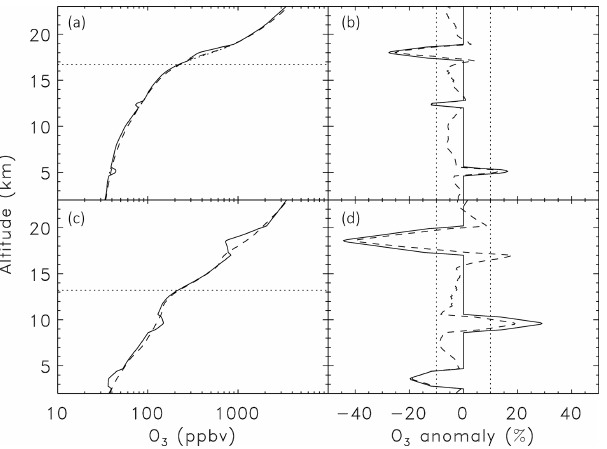
Figure 3. Panel (a) shows vertical profiles of ozone (blue) and scaled potential temperature anomalies (red) from a Boulder ozonesonde sounding on 4 May 2006. Vertical dashed lines rep- resent a 10% amplitude threshold for defining laminae, and seven identified laminae are indicated by number. Panel (b) shows the cor- relation coefficient calculated between ozone and potential temper- ature anomalies using a 5km wide sliding vertical window (solid curve), and alternatively from windows centered on individual lam- inae (orange and green bars). The dashed vertical line indicates the 0.7 threshold used for identifying gravity wave ozone laminae with the 5km sliding window technique. For correlations over individual laminae, a 0.65 threshold value is adopted, and laminae meeting or exceeding this threshold are indicated by the green bars and classi- fied as GW laminae, while correlations below 0.65 are indicated by orange bars and classified as NGW laminae.